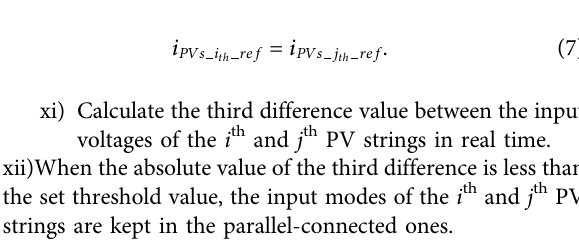
Frontiers in Energy Research |